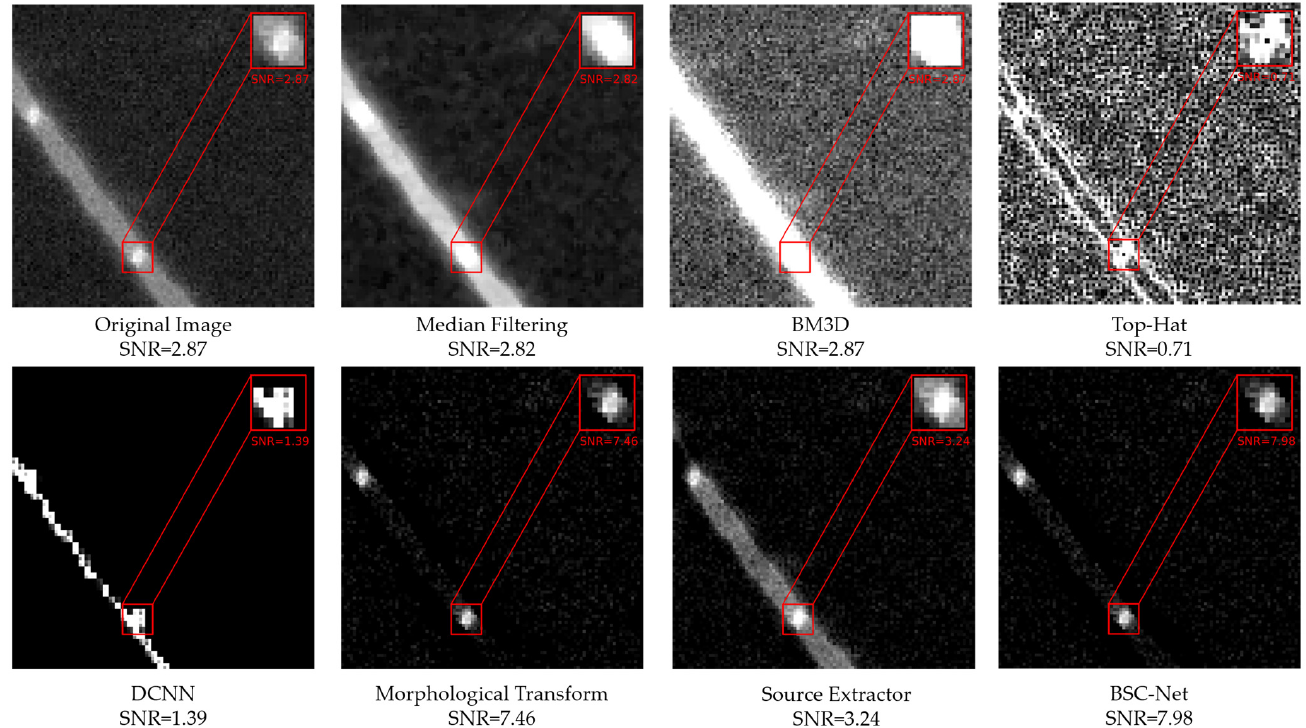
Figure 11. Results of linear fringe interference in different algorithms (RMS = 269.41).